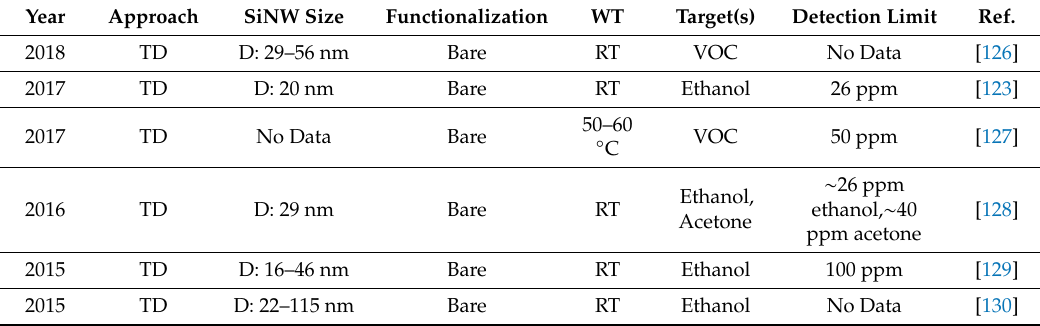
Table 2. Overview of Electrostatically Formed Nanowires gas sensors for the detection of di ff erent